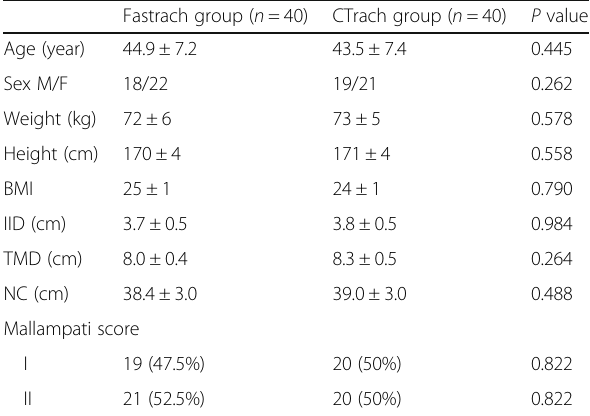
Table 1 Demographic data of the two study groups. Data are presented as mean ± SD for all parameters except Mallampati score where data are presented as absolute numbers and